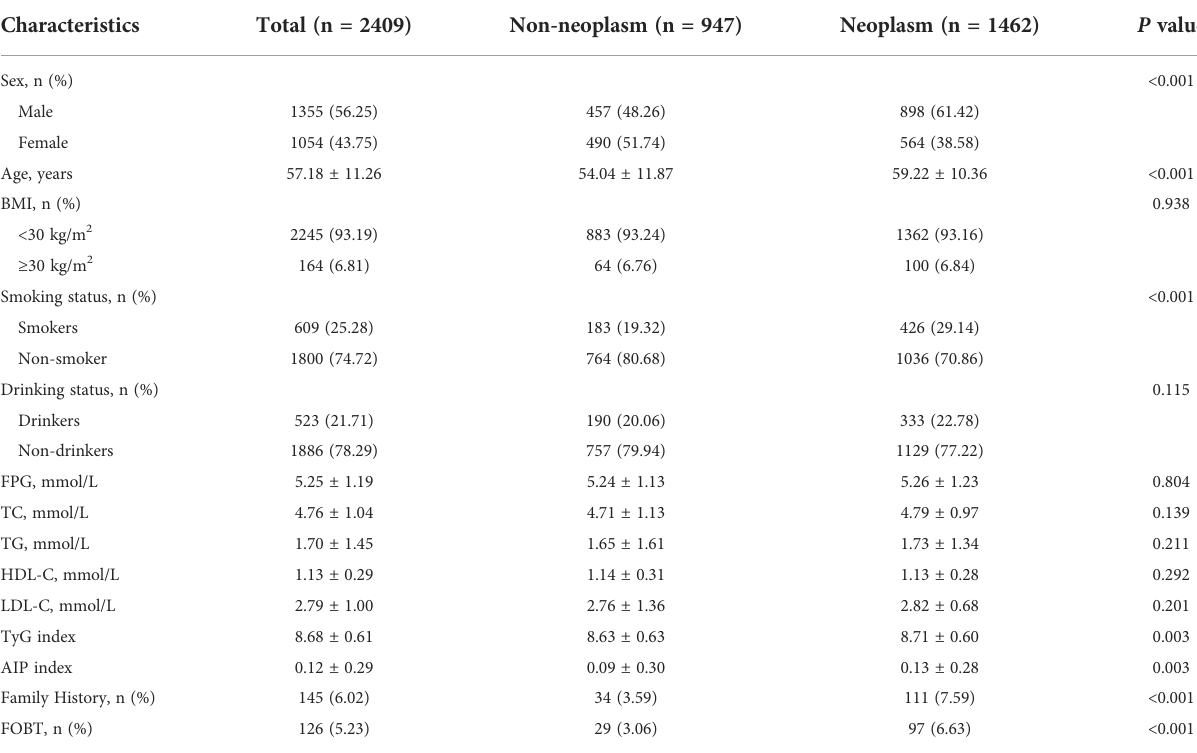
TABLE 1 Characteristics of the study